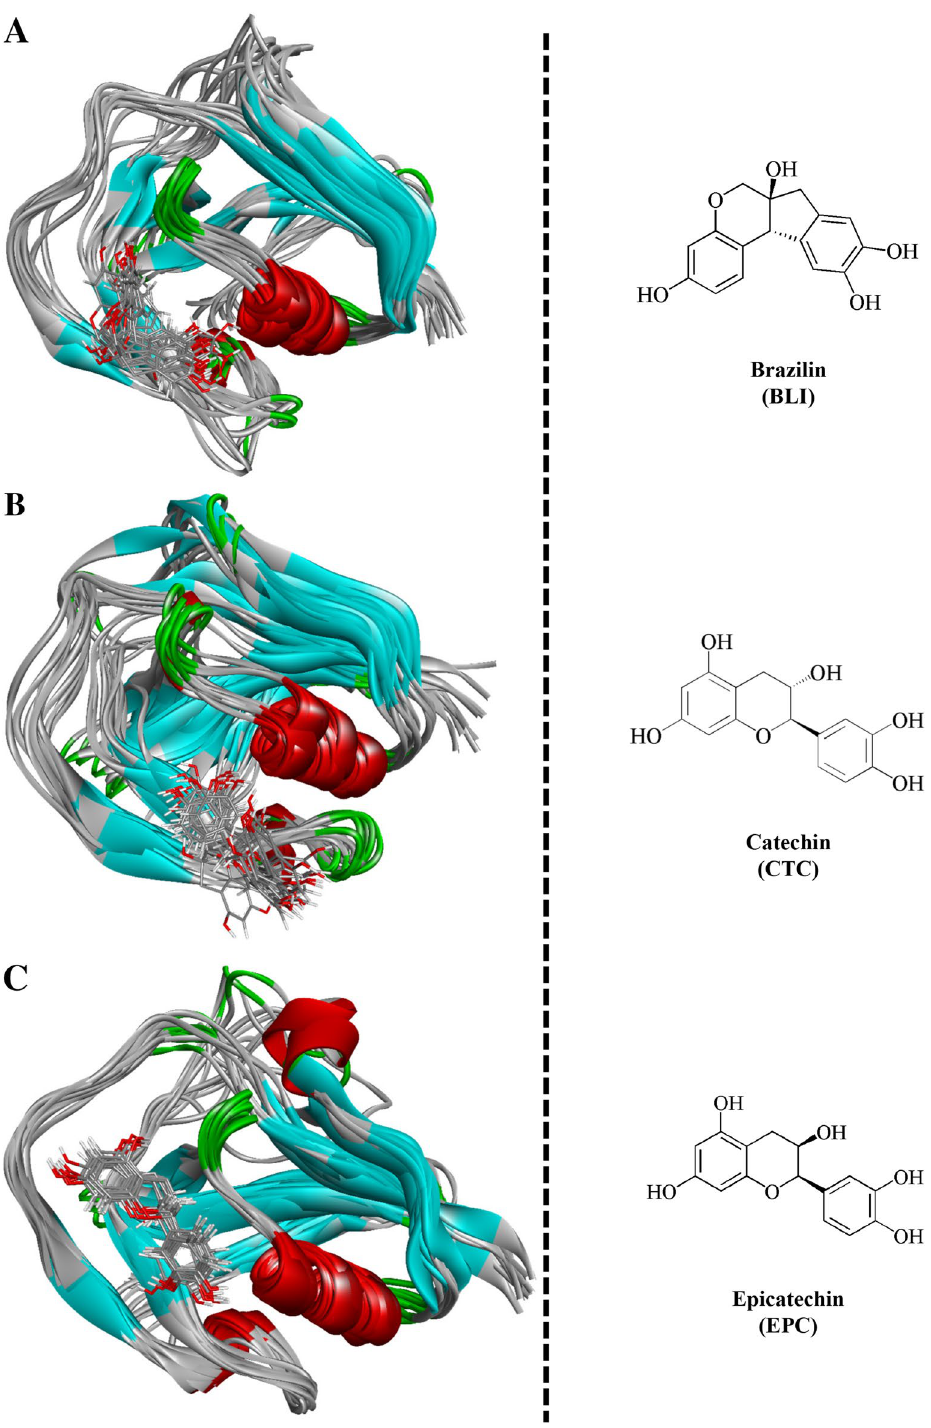
Figure 2. Molecular overlay of SRCR5-inhibitor complexes: ( A ) brazilin ( B ) catechin and ( C )